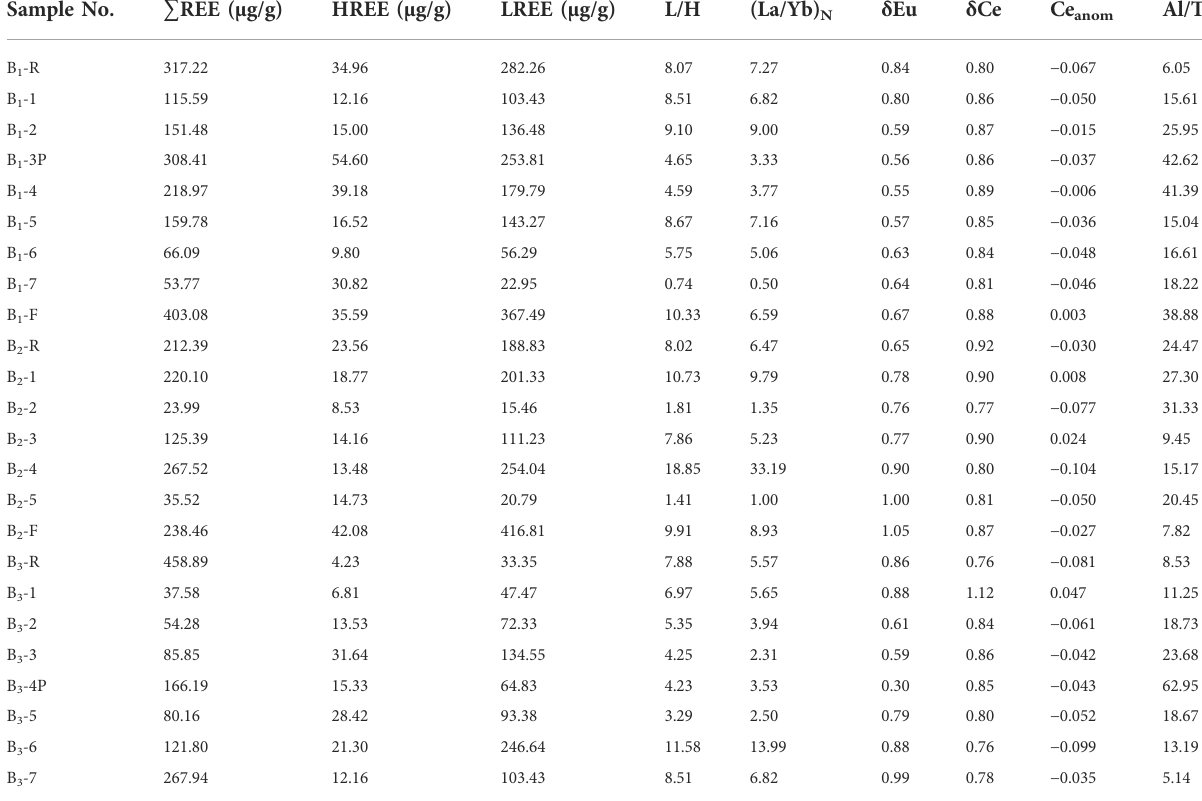
TABLE 3 The REE and elements data of the late permian coal seam samples from the Yantang Mine, Xuanwei, Yunnan. Sample